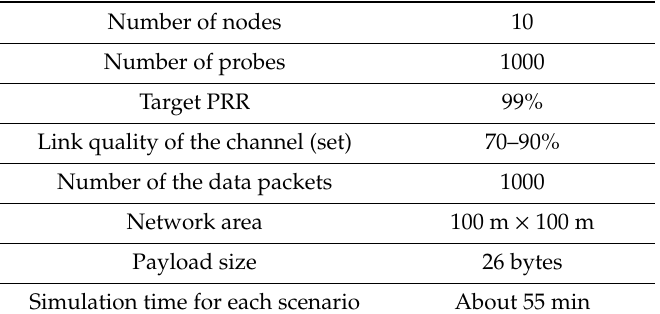
Table 2. Summary of the simulation set-up